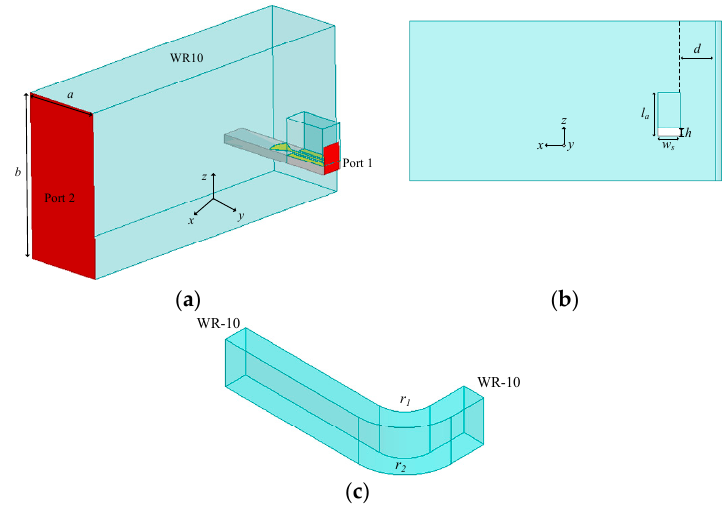
Figure 1. The configuration of the transformer. ( a ) 3D view; ( b ) side view; and ( c ) H plane bend.